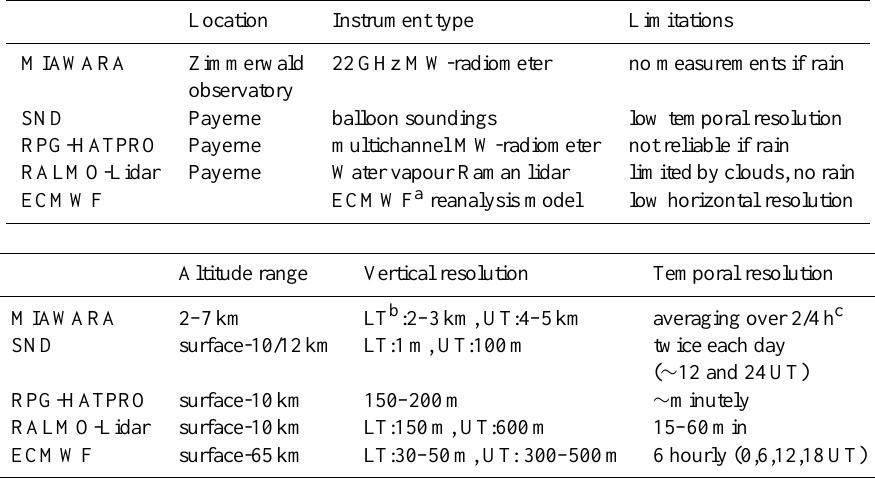
Fig. 13. Timeseries of H 2 O vmr for different altitude levels. Red: retrieved from MIAWARA (2h averaged spectra), blue: corresponding sounding data from Payerne (regridded to MIAWARA grid) and dashed: a-priori guess. Shown data is restricted to cases with near time- coincident sounding and retrieval profiles (mostly two cases per day). Table 1. Overview of instruments and datasets used for